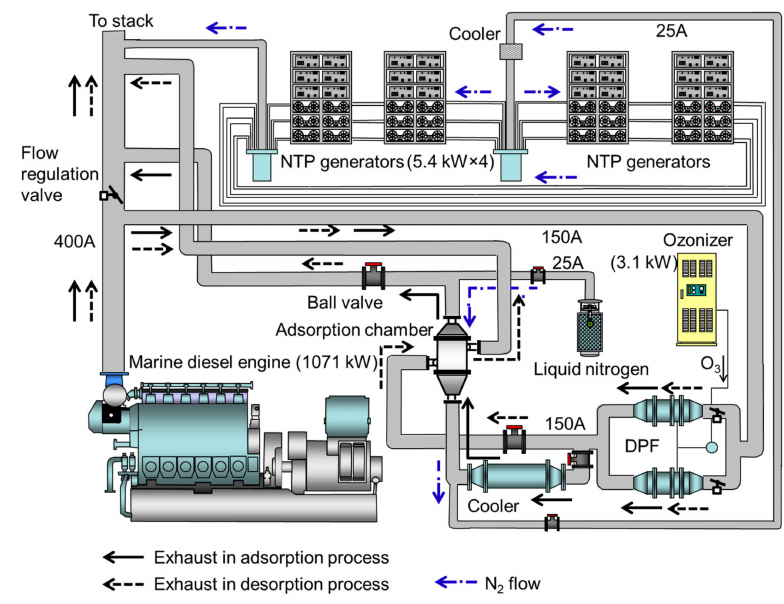
Figure 3. Schematic of the experimental setup for exhaust-gas aftertreatment in the marine diesel engine.